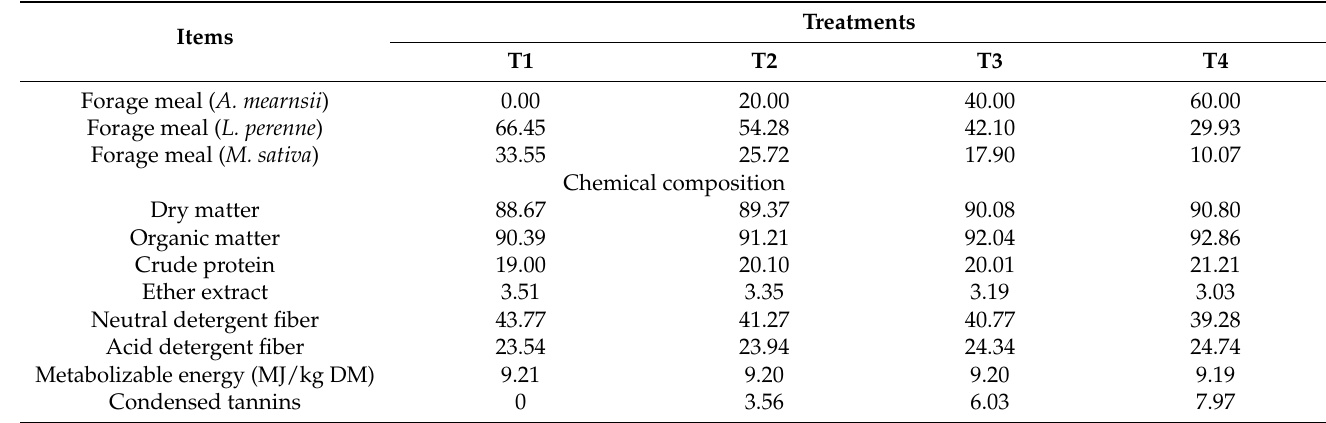
Table 1. Experimental treatments and chemical composition (% except where otherwise noted) of diets with increasing levels of Acacia